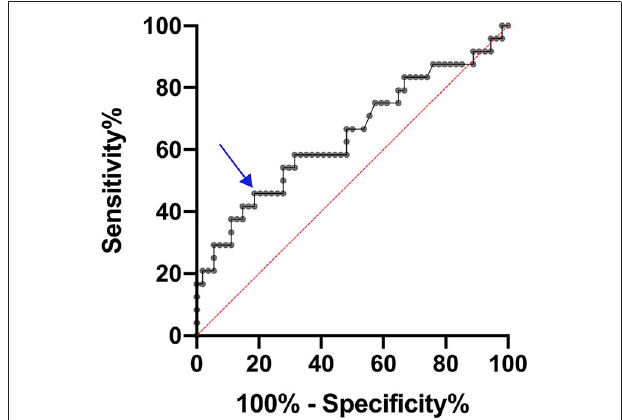
FIGURE 2 | ROC curve for predicting further cerebrovascular events through measure of plasma hs-CRP levels. The arrow shows the cut-off point of hs-CRP = 3.25 µ g/ml corresponding to 46% sensitivity and 81%